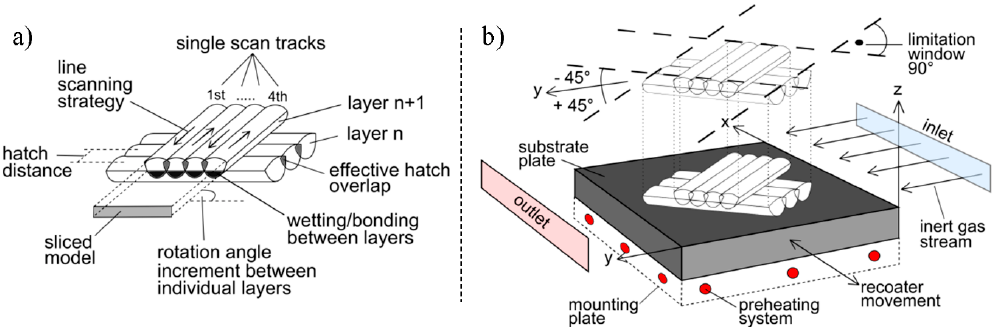
Figure 1. Schematic depiction of the SLM process; ( a ) the representation of the geometry via single scan tracks and layers; ( b ) the build environment; adapted from [8].